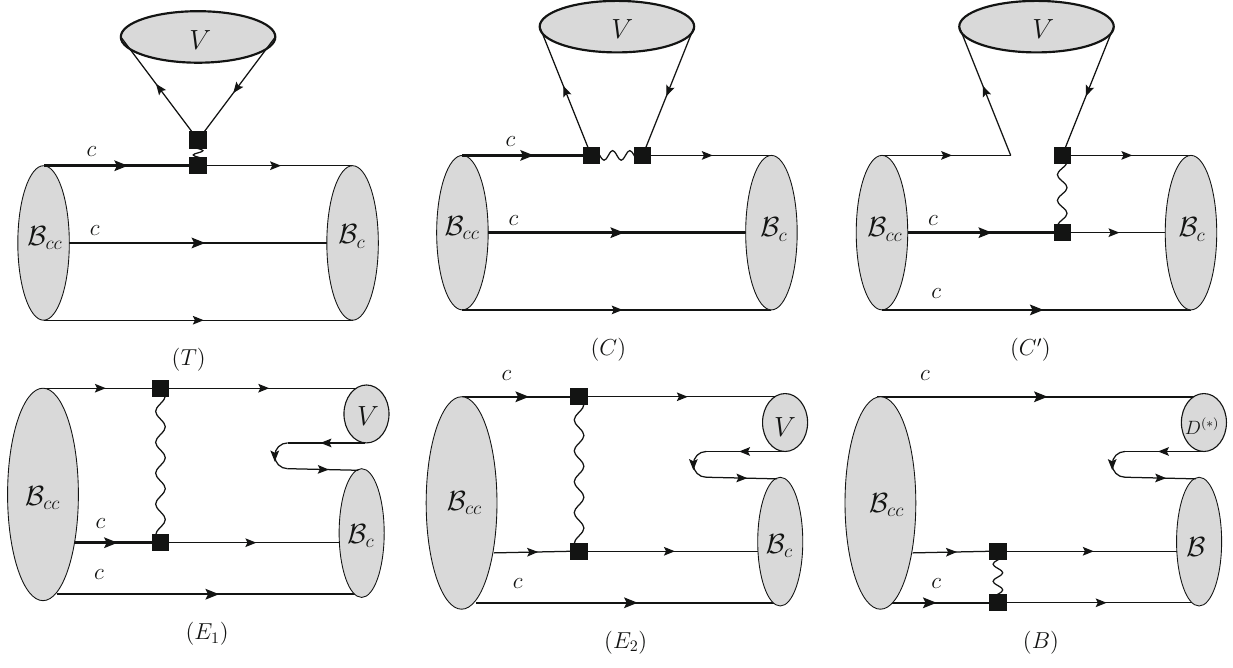
Fig. 1 Tree level topological diagrams for two body nonleptonic decays of a doubly charm baryons to a baryon and a meson. The wave lines sandwiched by two black squares denote where the four-quark operators are inserted. T denotes external W emission diagram; C rep- resents the internal W emission contribution; E labels W exchange